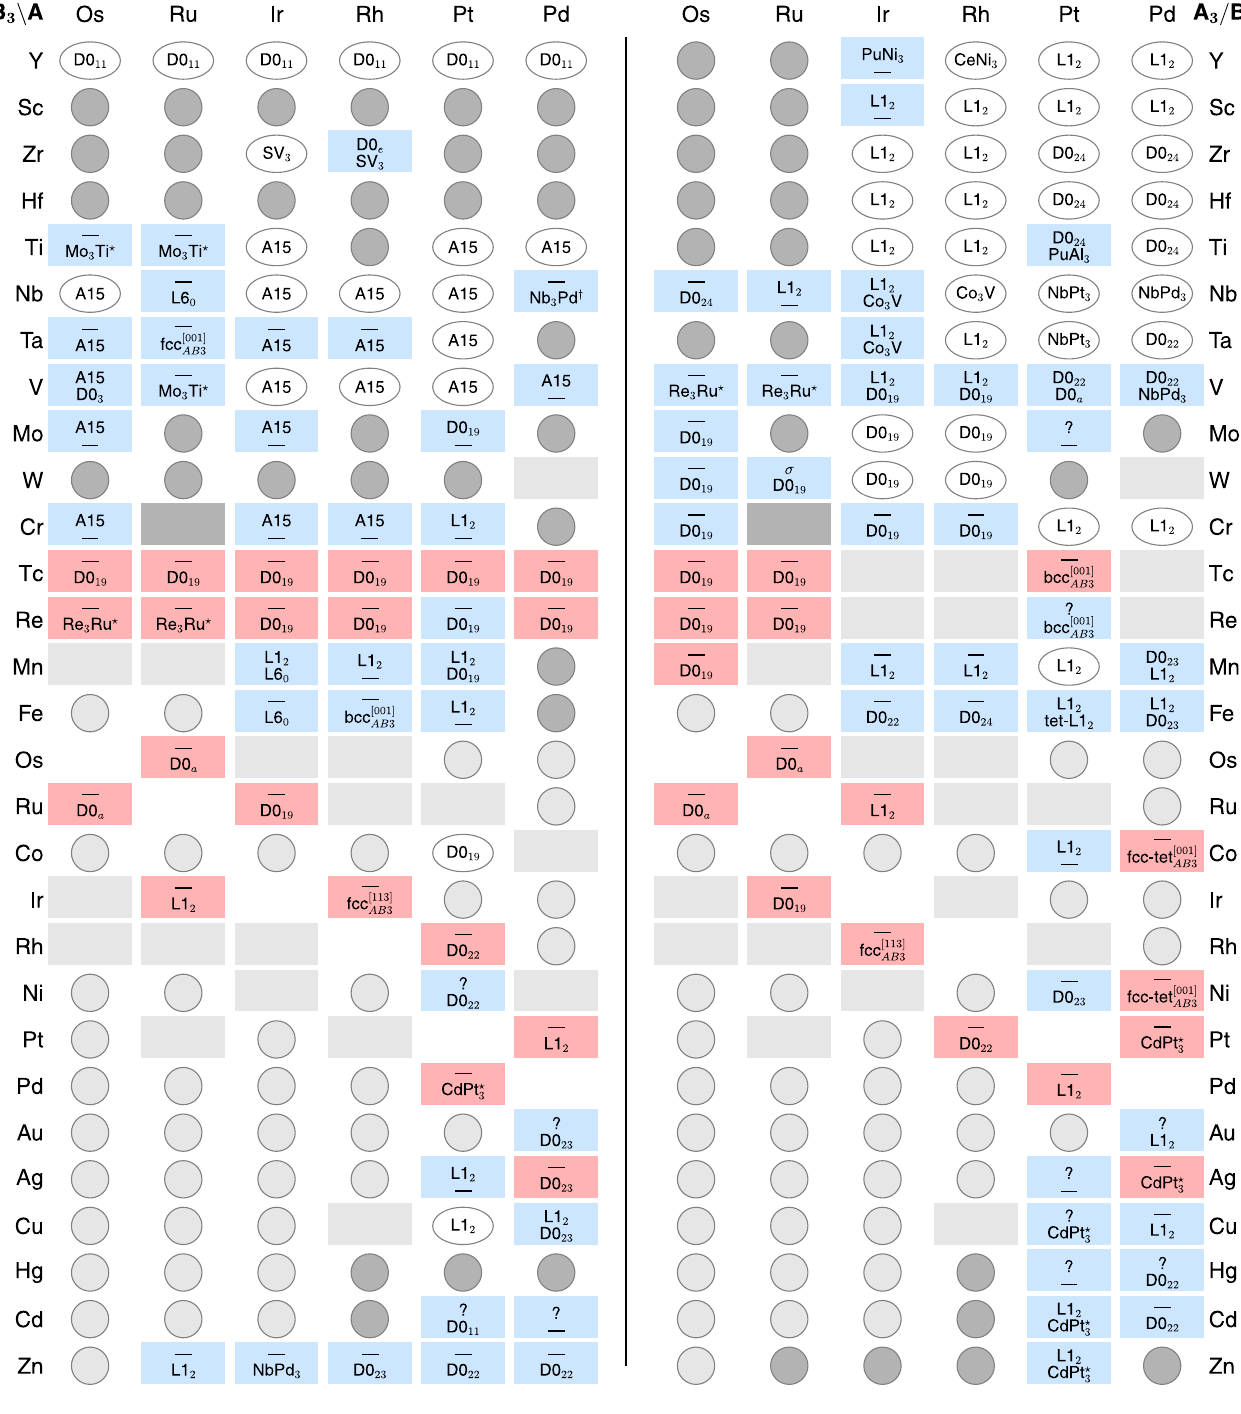
FIG. 4. A Pettifor-type structure map for 1:3 stoichiometry compounds in PGM binary systems. The symbols are as in Fig.